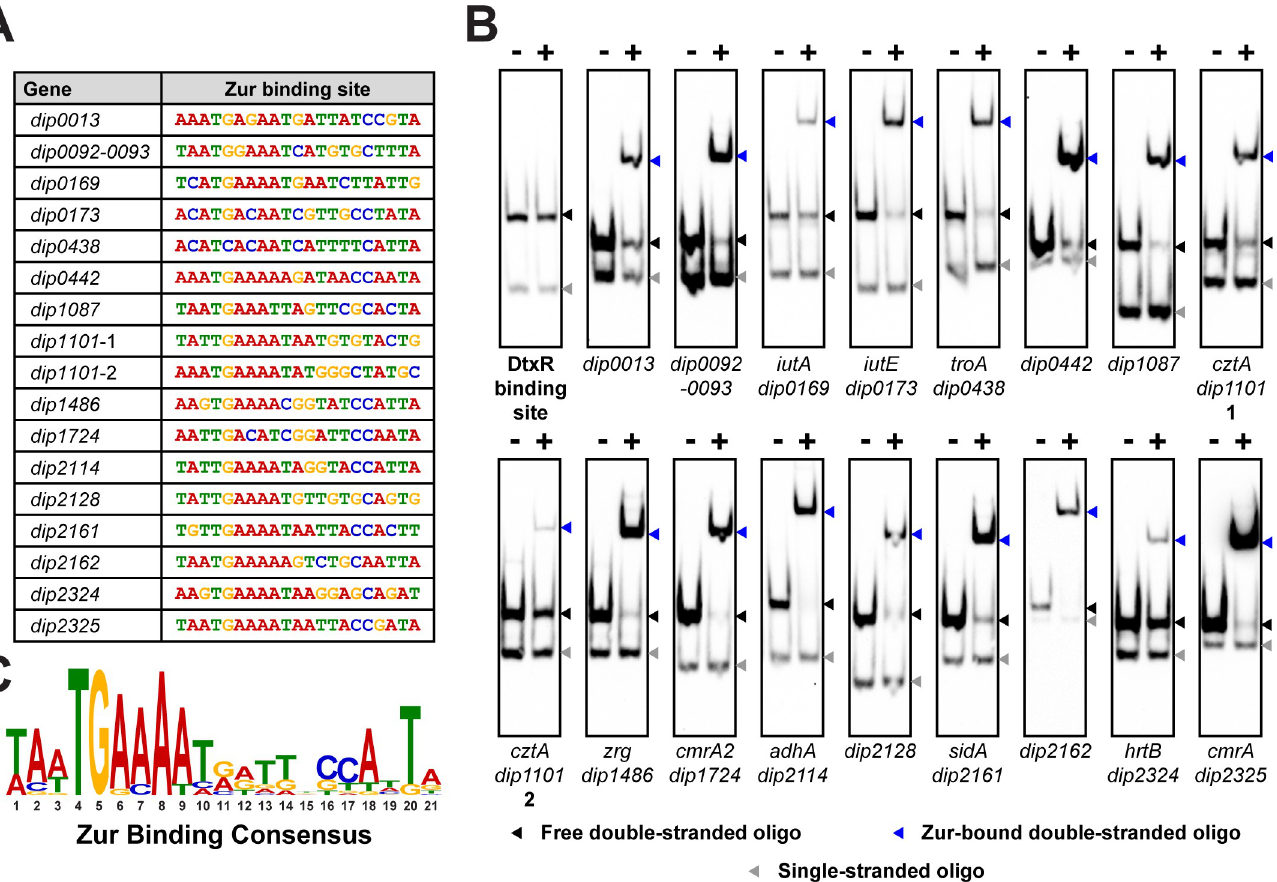
Fig 5. Identification of Zur binding sites. (A) Sequences for Zur binding sites predicted by MEME [26] found within putative promoter regions of indicated genes. The cztA gene ( dip1101) contains two potential binding sites (1 and 2). (B) EMSAs used 100 nM recombinant Zur and 1 nM biotinylated oligos containing the putative binding sequence. ( – ) indicates lanes in which no Zur was added; ( + ) indicates the addition of His-tagged Zur protein. The DtxR binding site of iutA was used as a negative binding control. Arrows indicate single-stranded oligo (grey), unbound double-stranded oligo (black), and Zur-bound double-stranded oligo (blue). 5 μ M zinc chloride was present in all binding reactions. The Zur binding consensus was generated from the binding sequences indicated in (A).